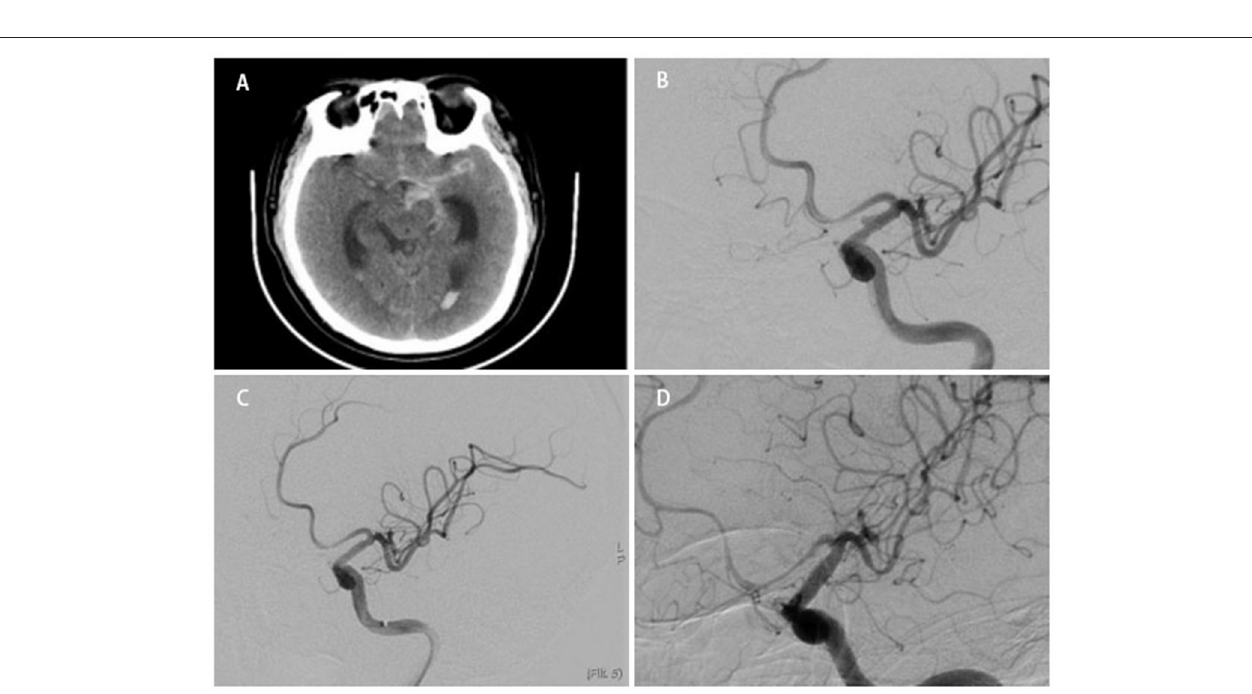
FIGURE 2 | A middle-aged person was admitted to our hospital for sudden headache 8h earlier (H-H grade 2). An emergency cranial CT revealed diffuse subarachnoid hemorrhage (A) . Cerebral angiography showed a BBA located at the side wall of the C7 segment of left ICA (B) . After a WCS (3.5 * 13mm) deployed successfully, the instant angiographic after once balloon dilation revealed no contrast filling into the aneurysm (C) . Angiographic follow-up at 4 months revealed total occlusion of the aneurysm (D) .